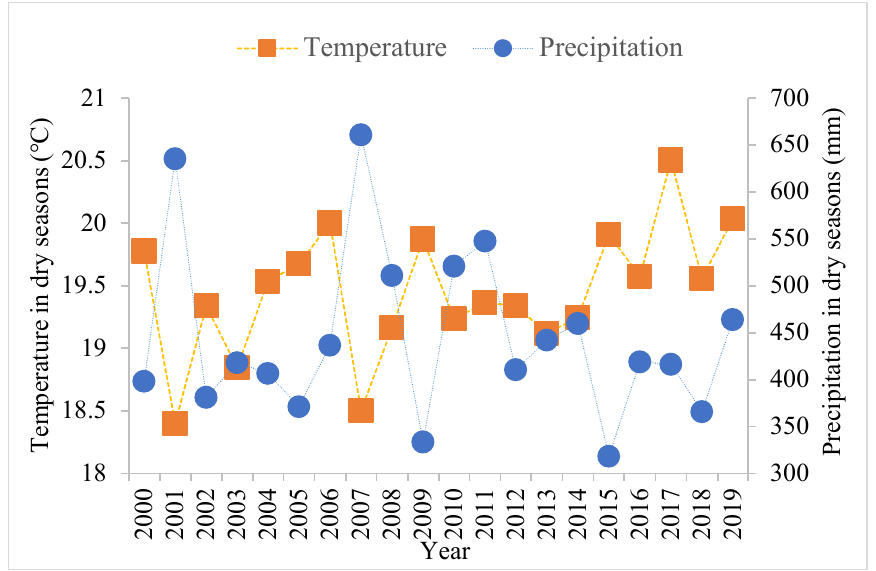
Figure 6. Annual average temperature and total precipitation of dry seasons in Mara River Basin.